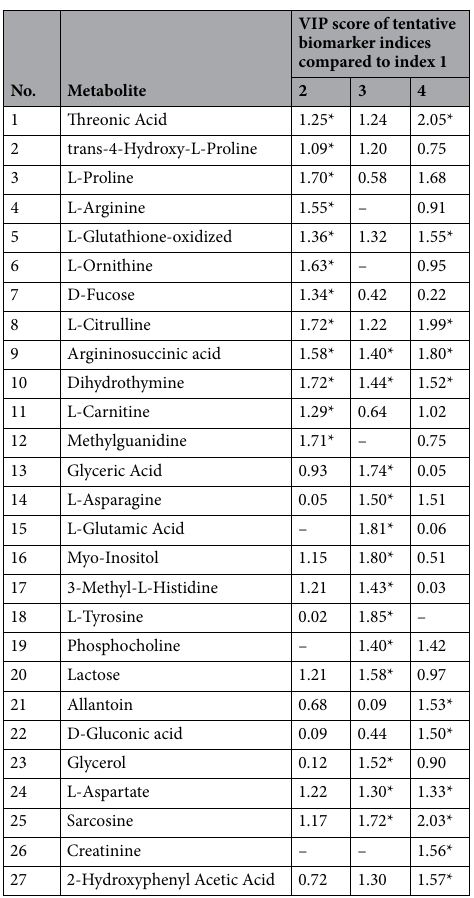
Table 1. List of biomarkers of G. boninense-infected oil palm stem tissue and their VIP scores obtained by OPLS-DA analysis at severity indices 2, 3, and 4 compared to index 1. *Indicates metabolite with AUC Score = 1 which is the potential candidate of biomarker for that